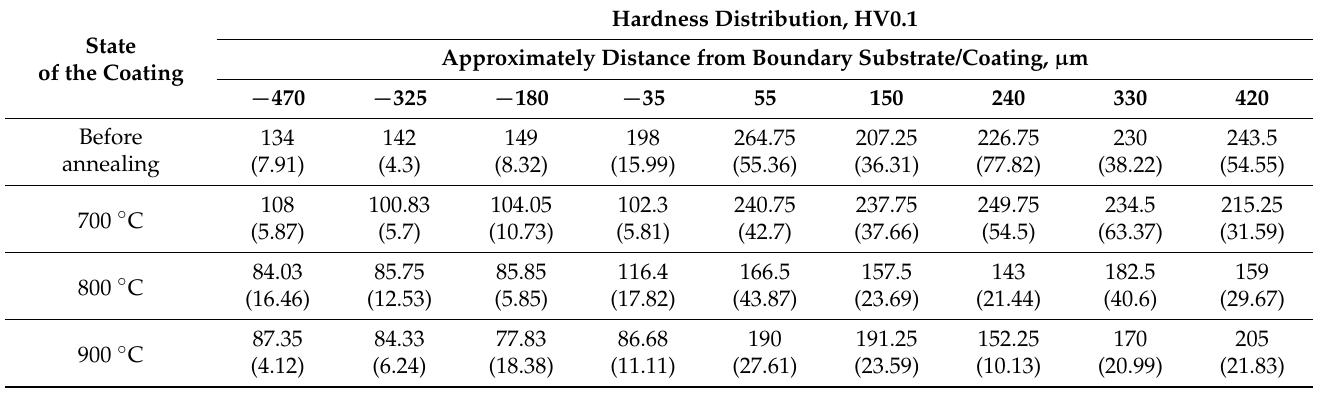
Table 4. Hardness distribution in cross-section of substrate coating system, before and after annealing; the table shows the average value and standard deviation for the hardness distributions for the charts from Figure 12. Hardness Distribution, State of the Coating